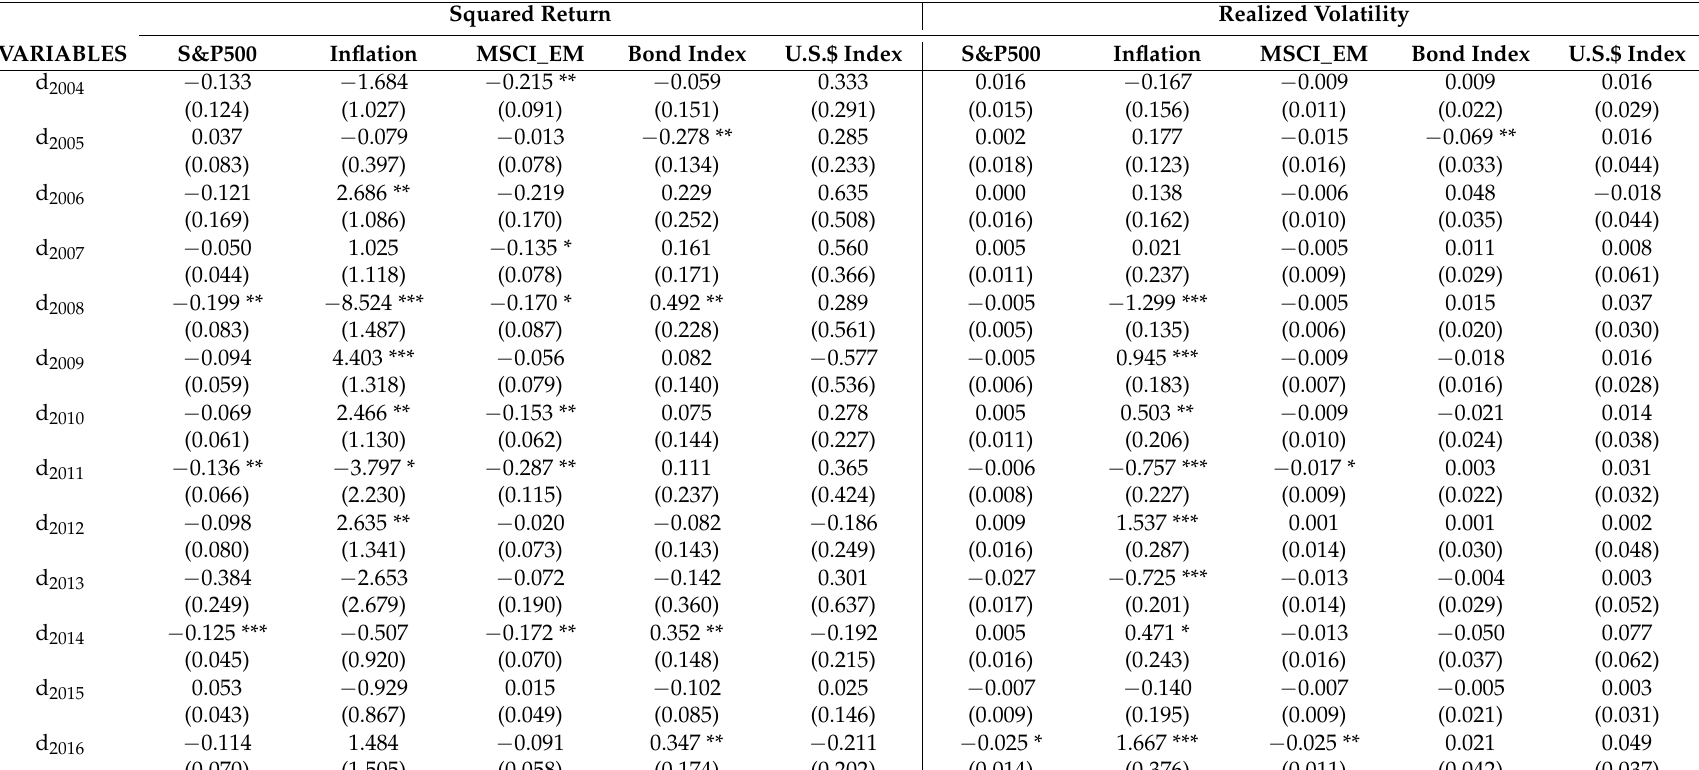
Table 6. Estimated coefficients of the difference-in-difference (DID) model with different